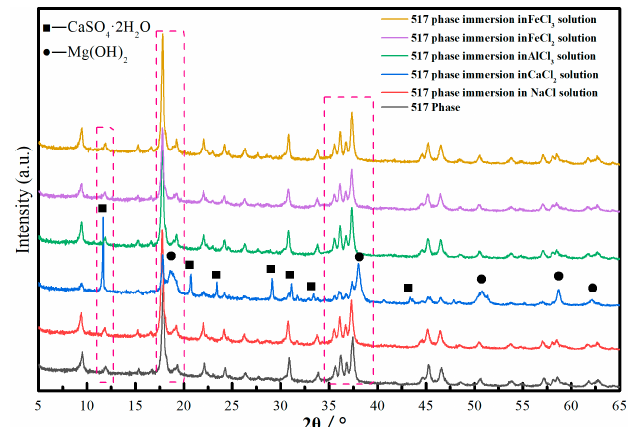
Figure 5. XRD patterns of 517 phase after immersing hardened paste in different chloride solutions for 28 days.